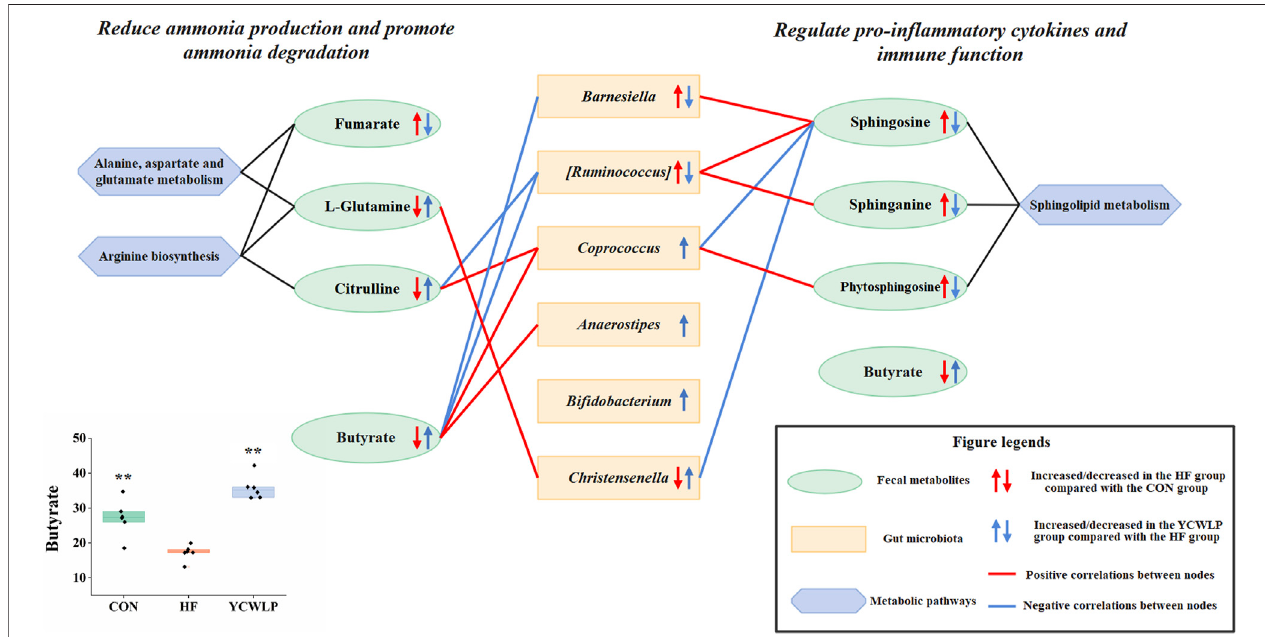
FIGURE5| MechanismofYCWLPinthetreatmentofHFbasedontheinteractions betweengutmicrobiota andhostmetabolism. Signi fi cantdifferencecompared with the HF group: * p -value < 0.05; ** p -value < 0.01.